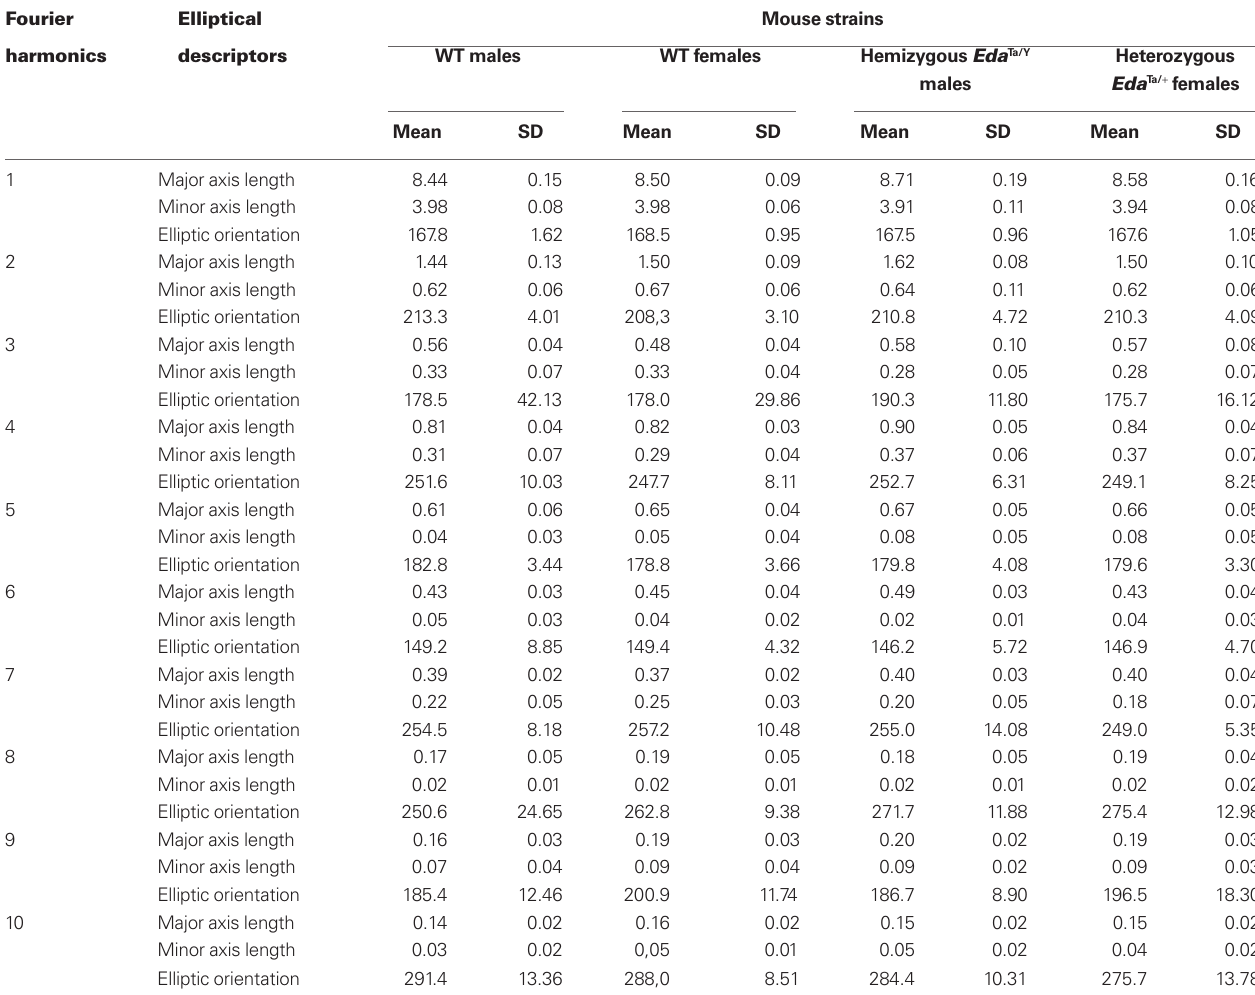
Table 1 | elliptical Fourier analysis of the lateral outline of the mandible in WT, Eda Ta/Y , and Eda Ta/ + mice. Summary statistics of the elliptical descriptors of the first 10